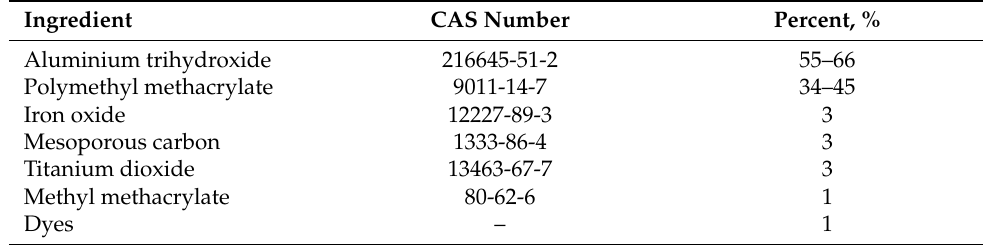
Table 1. Composition of artificial